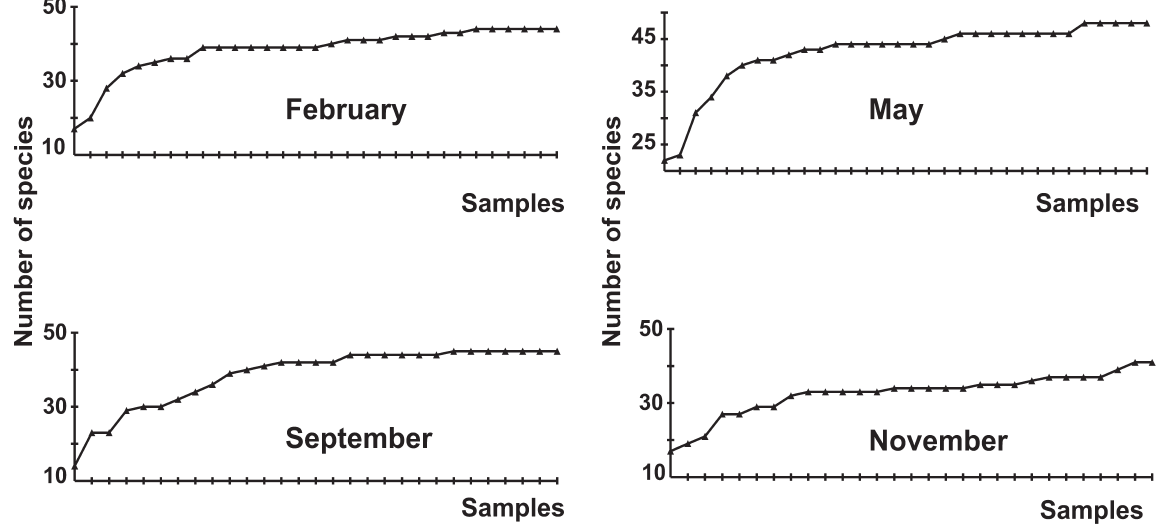
Fig . 3. – Accumulative richness for the whole studied area for the different